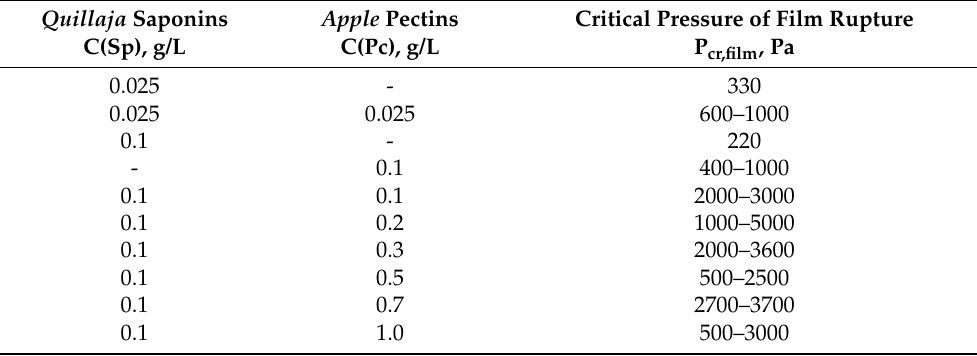
Table 2. Critical pressure of rupture of foam films from aqueous solutions of saponin-only, pectin-only and saponin/pectin mixtures, obtained using porous plate in